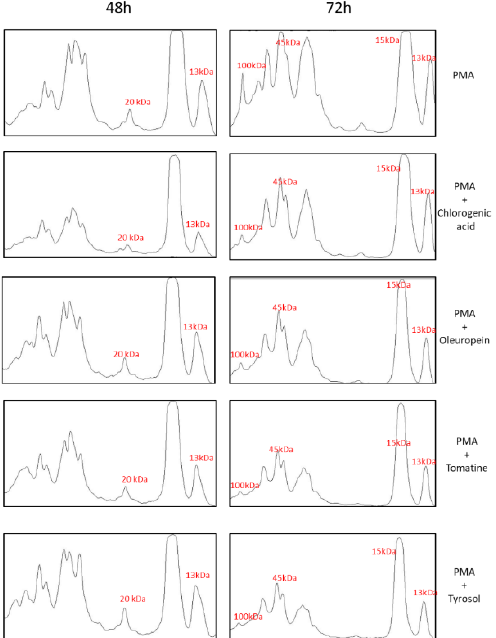
Figure 6. Identification of protein MDA adducts in whole-cell homogenates of U-937 cells treated with bioactive compounds PMA or PMA + bioactive compounds. Anti-MDA blot represents protein modification in U-937 cells differentiated for 48 h ( A ) and 72 h ( B ).